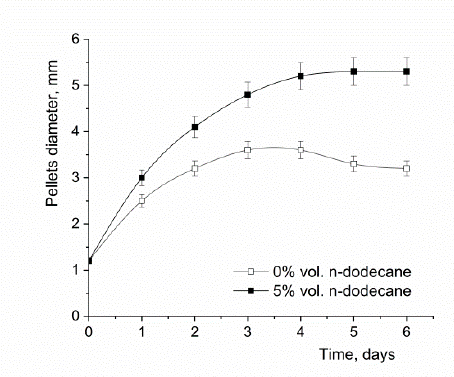
Figure 2. Comparison between the pellets’ size in absence and presence of n-dodecane.